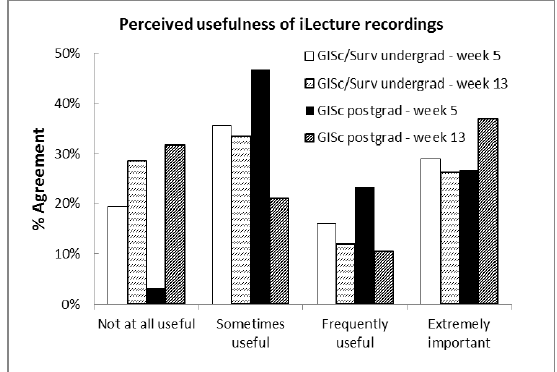
Figure 1: Students' perceptions of the usefulness of iLecture recordings